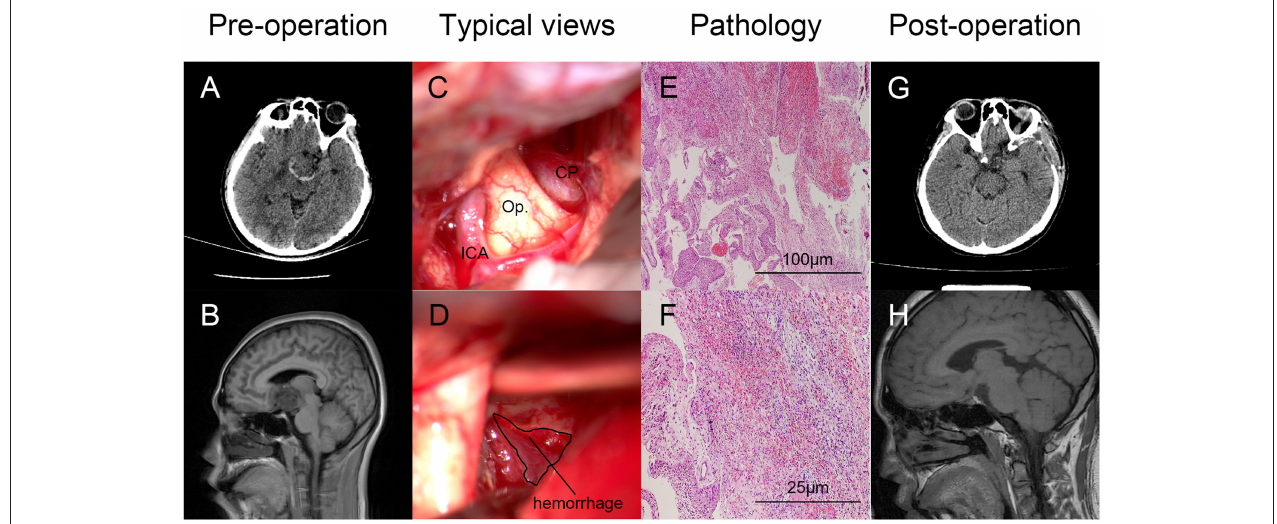
FIGURE 1 | Typical case illustration of craniopharyngioma (CP) with tumoral hemorrhage. Pre- (A,B) and post-operative (G,H) radiological images (axial CT and sagittal MRI) showed the hemorrhage around the lesion (A) and gross total resection (GTR) of the tumor. Intraoperative views of the tumor and hemorrhage around the tumor of Patient No. 2 were displayed as a typical case (C,D) . Hemorrhage was labeled with a circle. Pathological diagnosis confirmed the tumor as suprasellar CP with tumoral hemorrhage [ (E) , HE, × 100; (F) HE, × 400). CP, craniopharyngioma; ICA, internal carotid artery; Op., optic nerve.